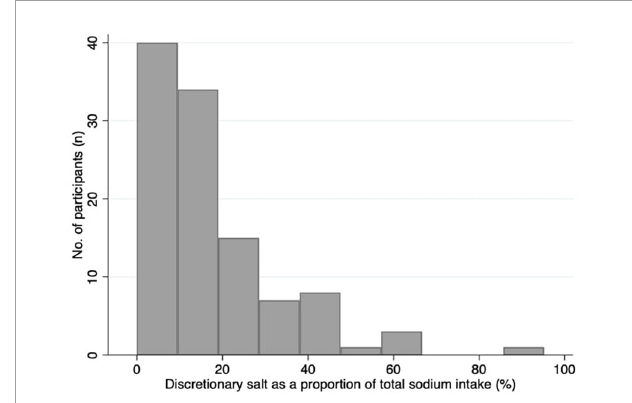
FIGURE3 Histogram of the proportion of sodium intake from discretionary salt as a percentage of total sodium